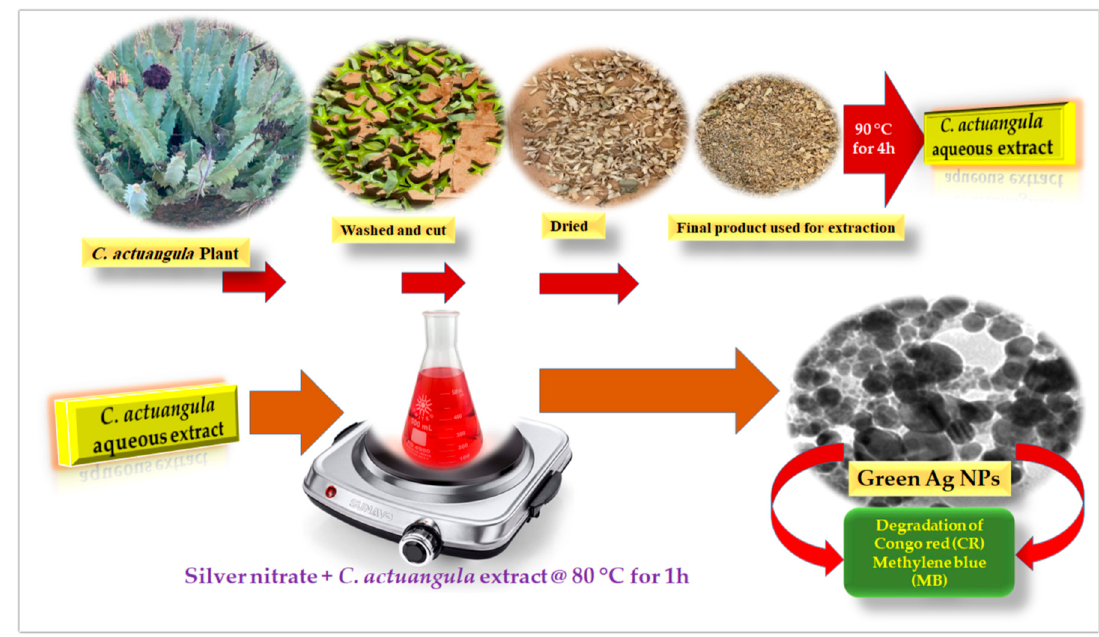
Figure 1. Schematic workflow of the study.